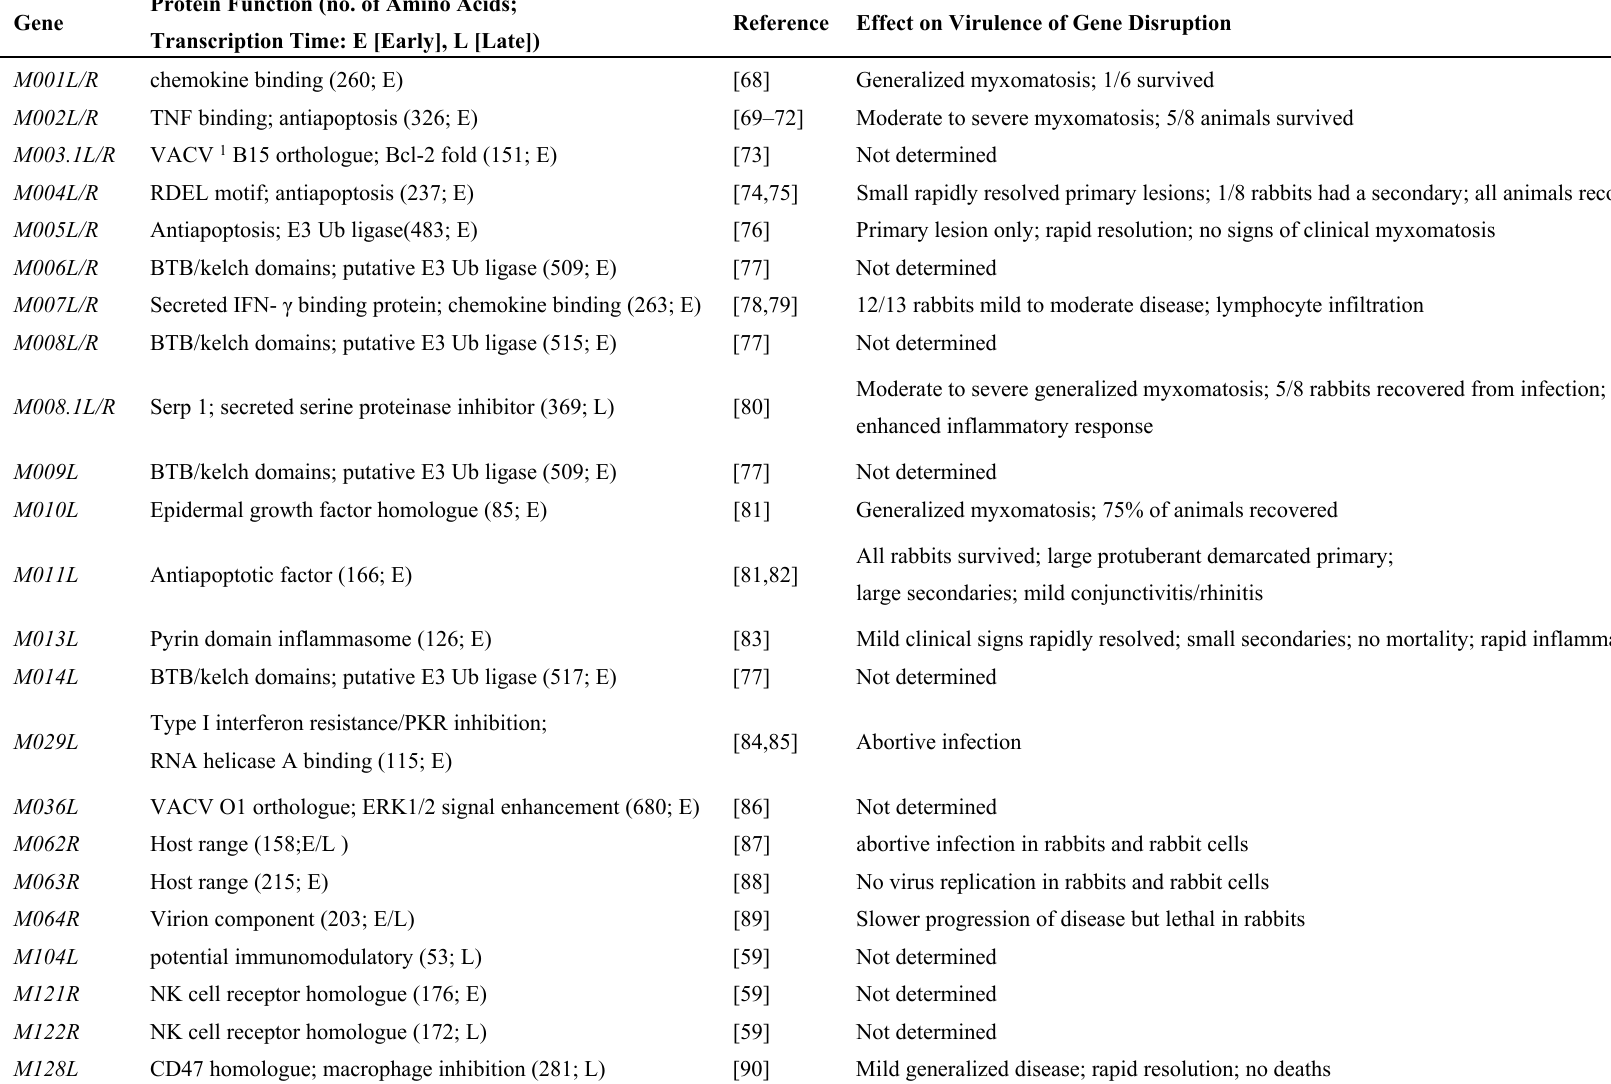
Table 2. Genes in myxoma virus encoding demonstrated or potential immunomodulatory or host-range